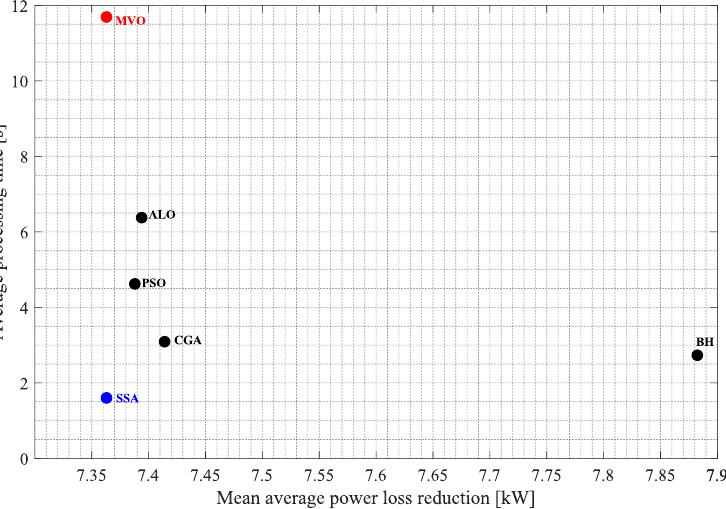
Figure 7. Trade-off provided by the solution methodologies between mean average power losses and required processing time in the 21-node